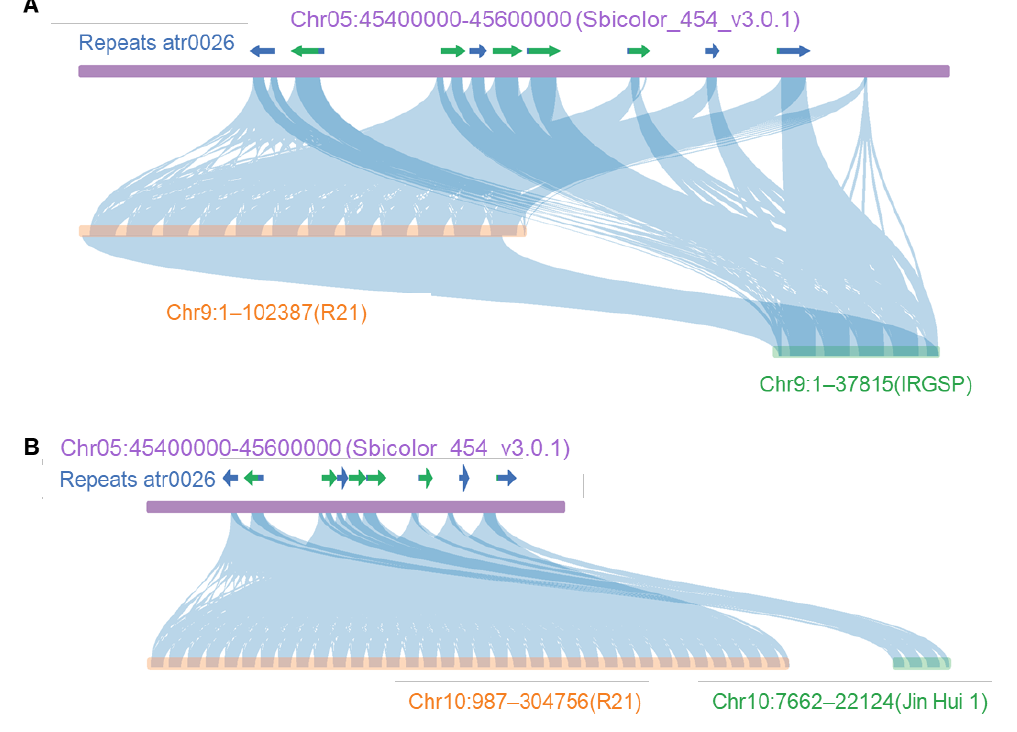
Figure 4. Collinearity analysis of sorghum insertion sequences. ( A ) Collinearity analysis between Sorghum insertion sequence and chromosome 9 of rice (from top to bottom: sorghum Chr05: 45.4–45.6 Mb fragment, repeat annotation atr0026, chromosome 9 segment of R21 genome, chromosome 9 segment of IRGSP genome); ( B ) Collinearity analysis between sorghum insertion sequence and chromosome 10 of rice (from top to bottom: sorghum Chr05: 45.4–45.6 Mb fragment, repeat annotation atr0026, chromosome 10 segment of R21 genome, partial fragment of chromosome 10 in Jin Hui 1 genome). Consistency between sequences was greater than 90%. Arrows represent repeats atr0026, and blue and green are used to distinguish the atr0026 overlapped.